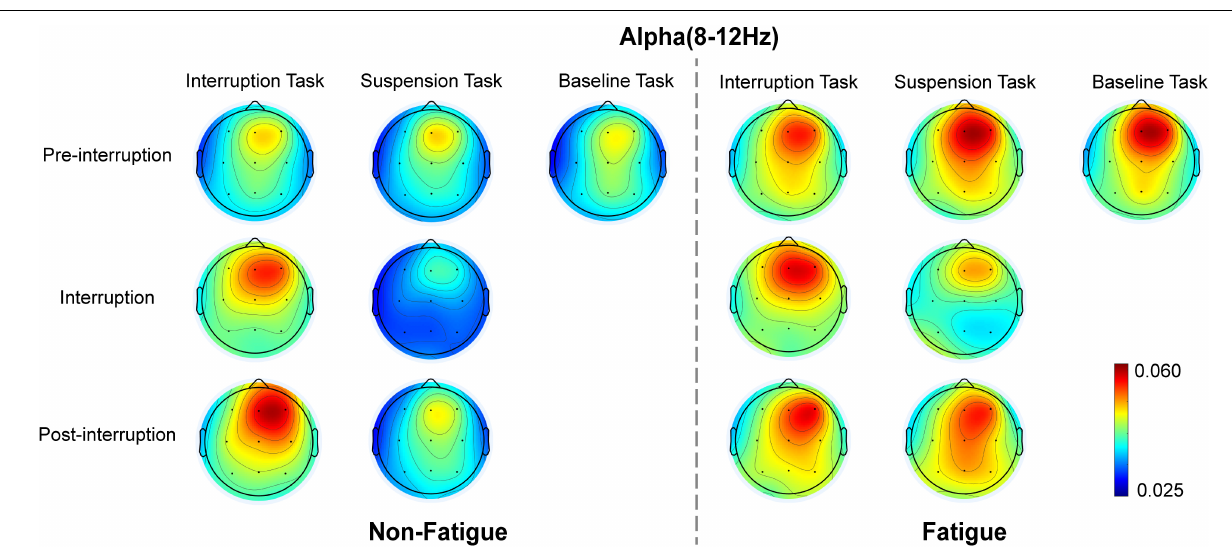
FIGURE 10 | Topographic representation of the grand average of the relative alpha energy in various